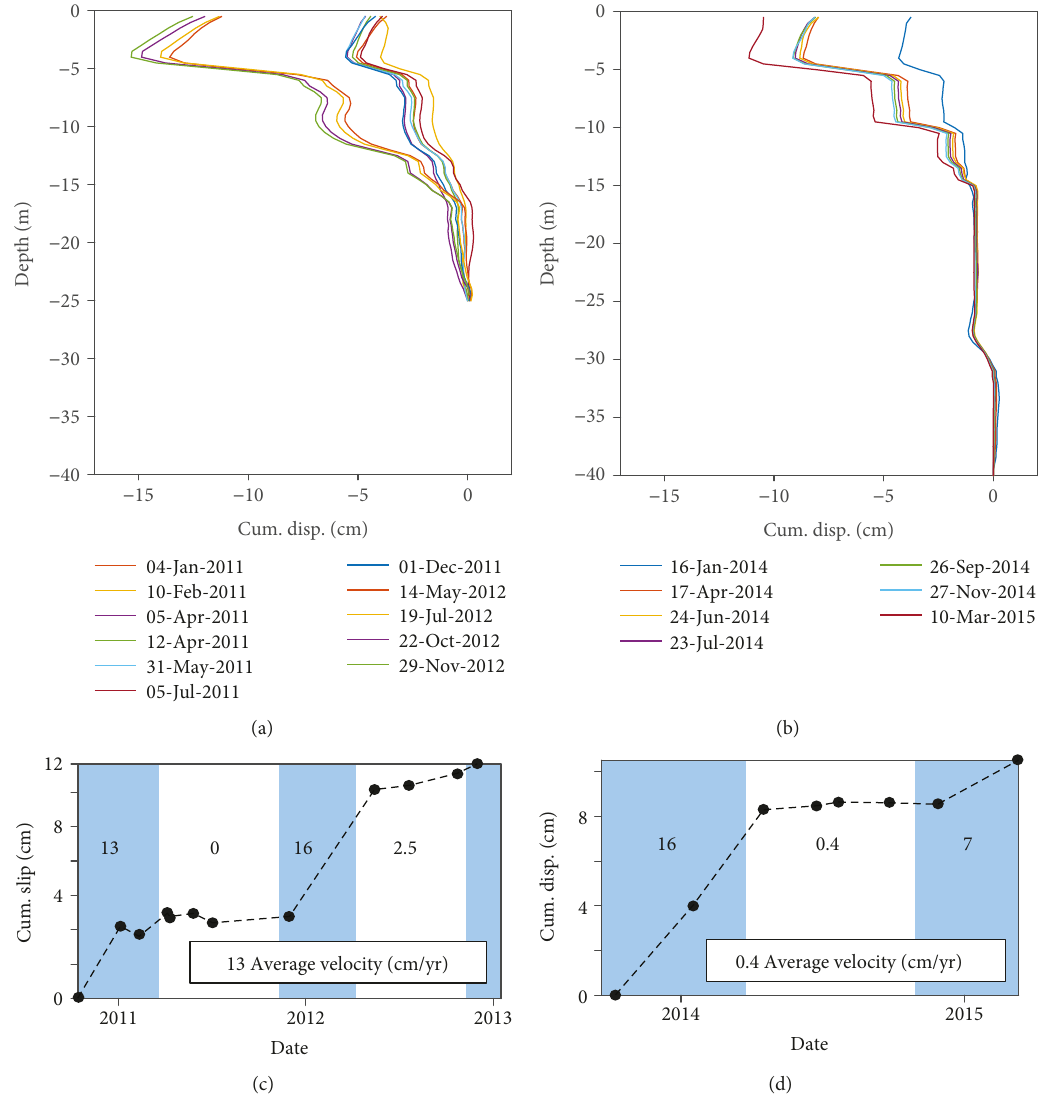
Figure 6: Inclinometer data for (a) i1 and (b) i2. (c) and (d) Extraction of cumulated displacements at 4m to 5m depth for i1 and i2, respectively. The blue and white bands correspond to the autumn-winter season (November to March) and to the spring-summer season (April to October), respectively. Values inside the graphs correspond to the average velocity, in cm/yr, for each